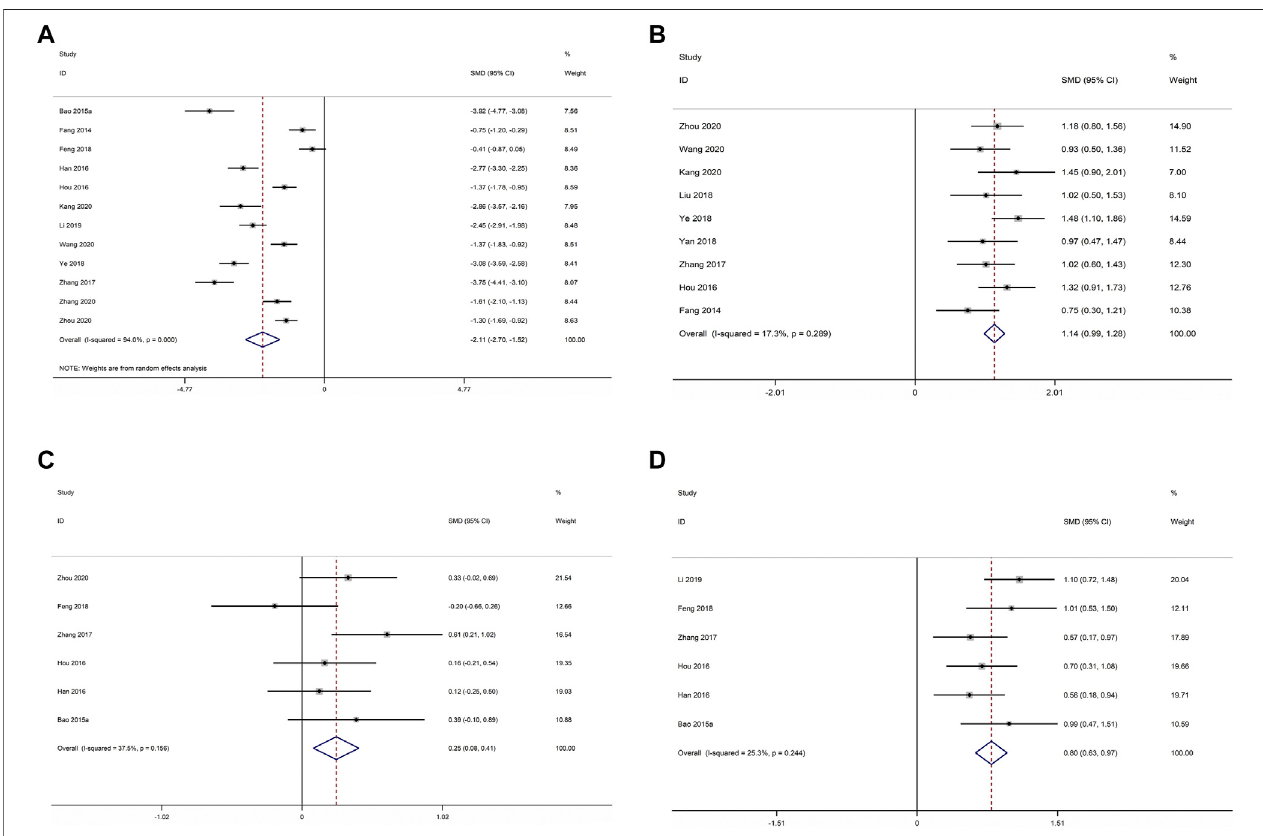
FIGURE 3 | Forest plot of XLGB combined with ALE vs. ALE alone with regard to ALP (A) , BGP (B) , S-Ca (C) , and S-P (D) .